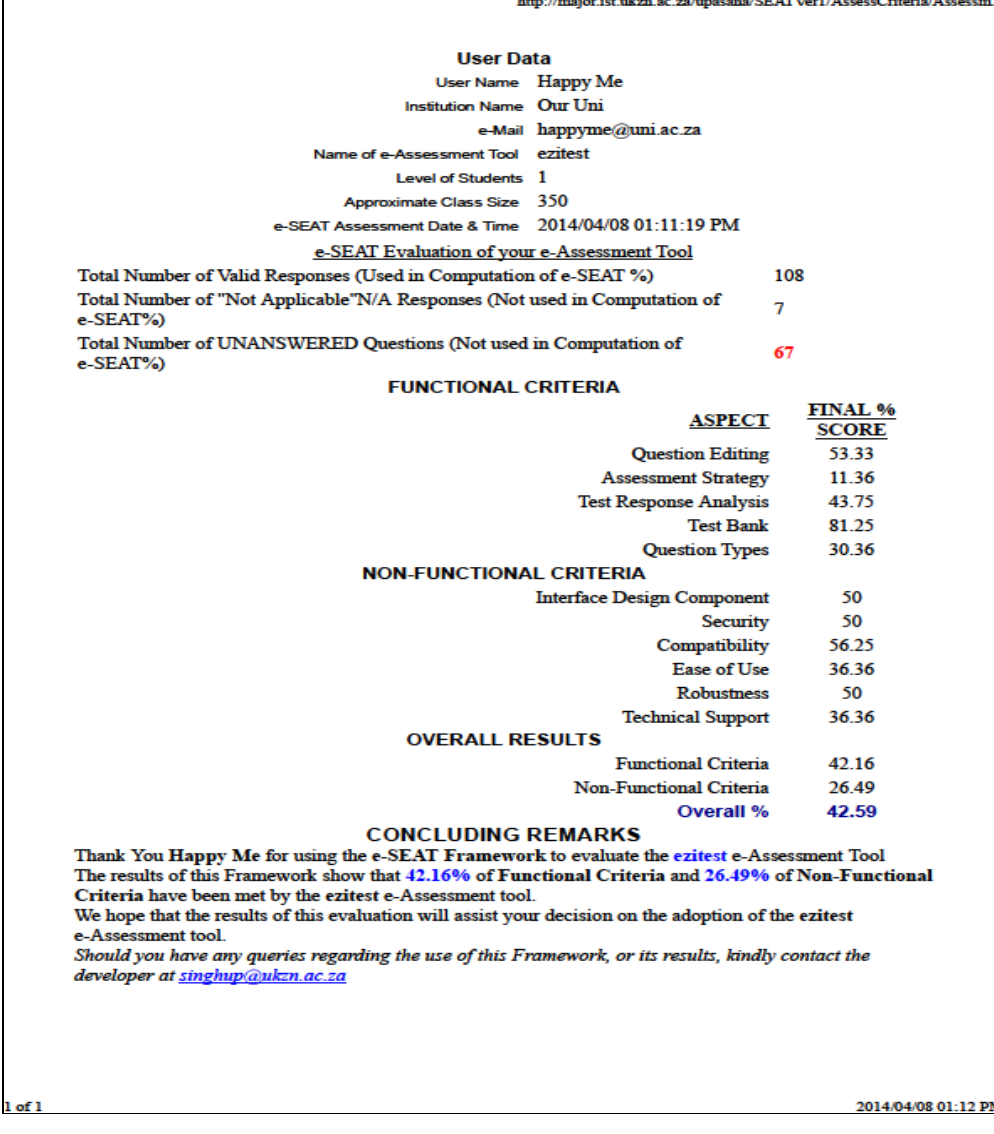
Figure 6. e-SEAT Sample Report